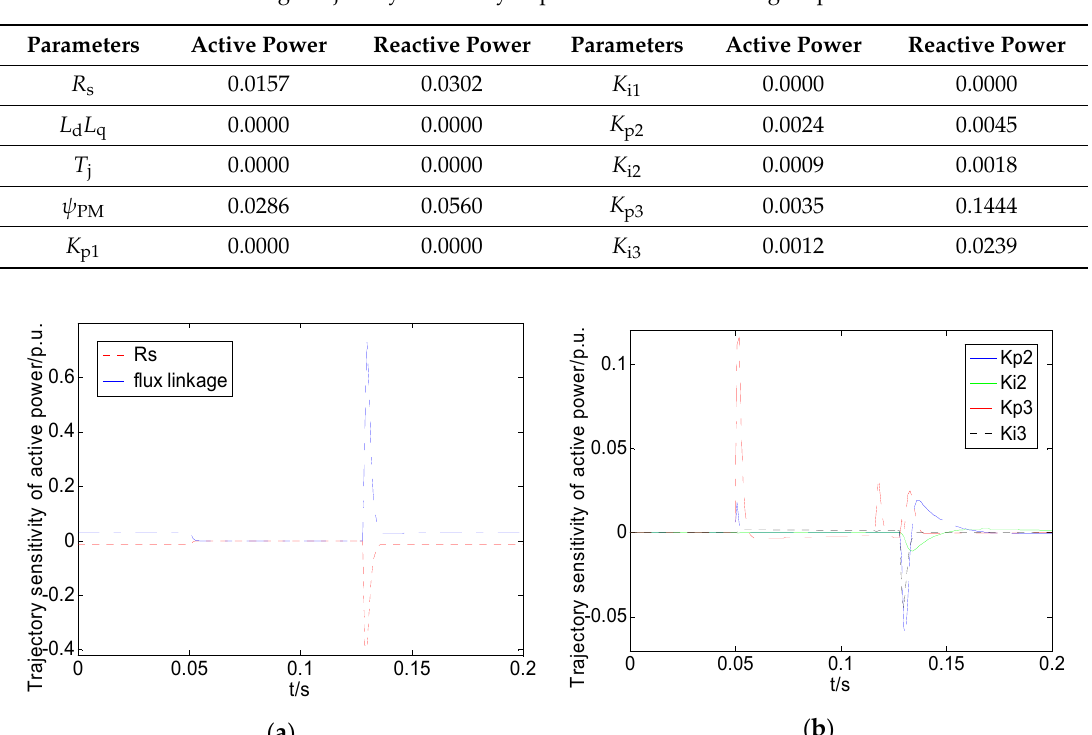
K , K and K , p2 p3 i2